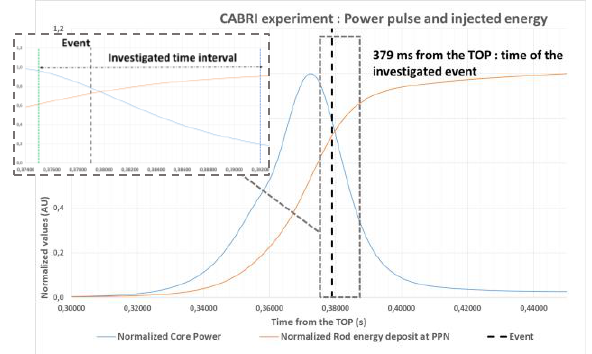
Fig. 4. Core power and rod energy deposit during the pulse.